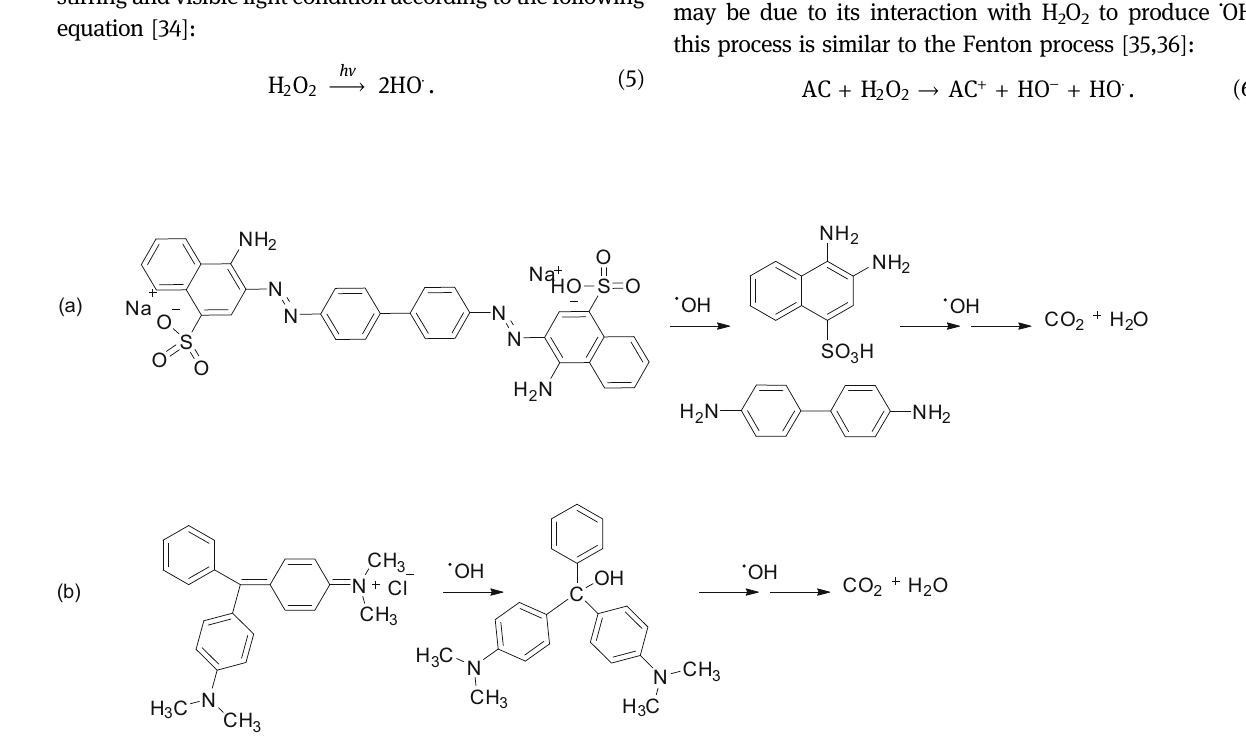
Figure 5: Summary of the removal pathway of ( a ) CR and ( b ) MG [ 32,33 ] .